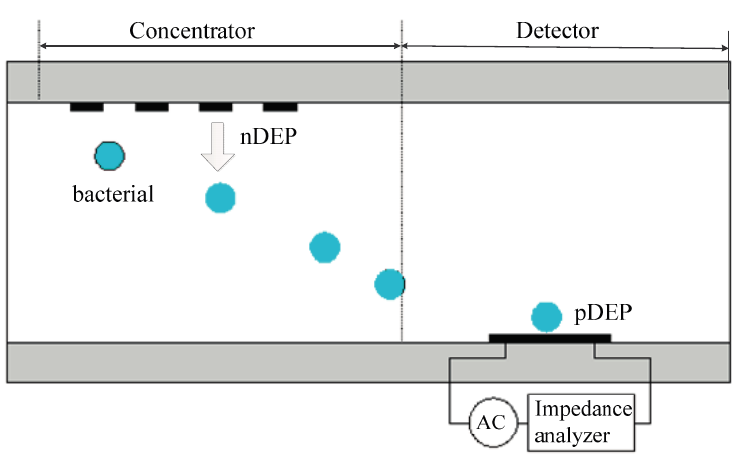
Figure 4. Schematic diagram of the bacterial detection chip based on nDEP and pDEP